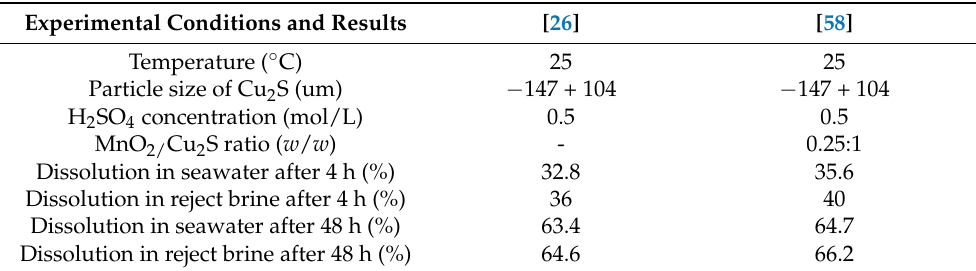
Table 7. Comparison of chalcocite dissolution with reject brine and the effect of MnO 2 . Experimental Conditions and